Question: Sum up the contents of this chart in one sentence.
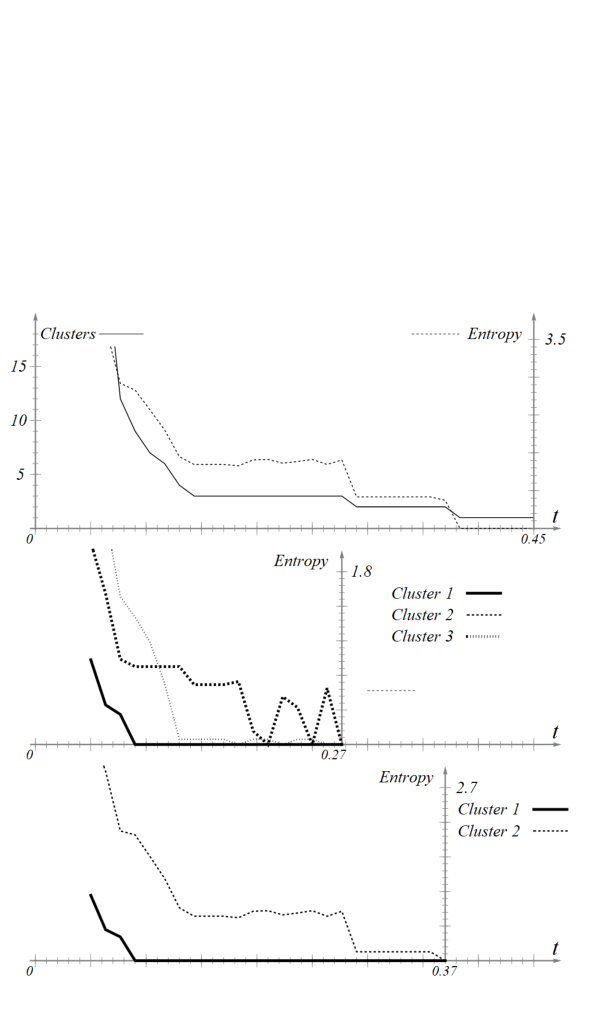
Answer: Top: Number of clusters and entropy. Middle: Local entropy analysis for the three clusters observed at t18 ≈0.28, showing notable stability in Clusters 1 and 2, but substantial instability in Cluster 3. Bottom: Local entropy scores for the two clusters observed at t25 ≈0.37 showing a very long period of zero entropy for Cluster 1.